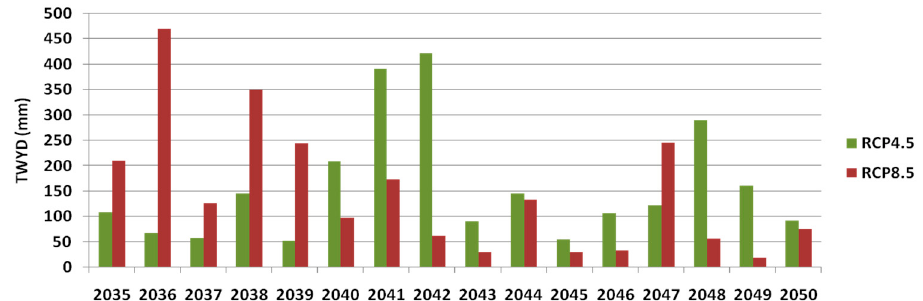
Figure 3 . Distribution of annual TWYD averages under both RCPs over 2035–2050 period.